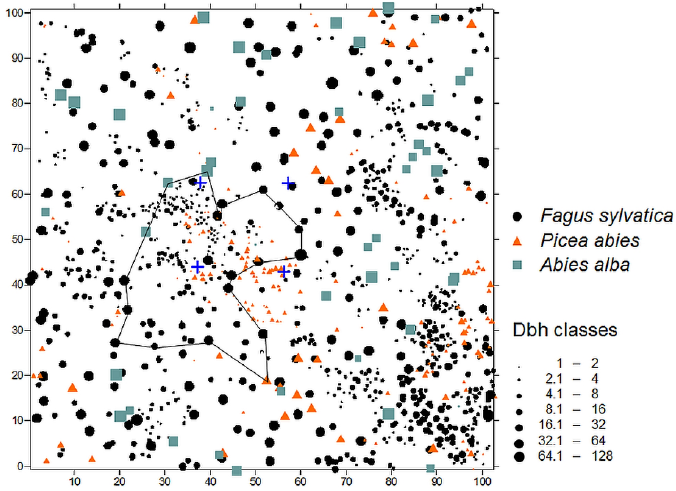
Figure 1. Spatial pattern of trees in permanent study plot (PSP) 1 at Rothwald. The crosses denote the corners of the 20 m × 20 m inner plot. The solid line marks gap formed in 1990 (expanded gap definition, sensu [42].